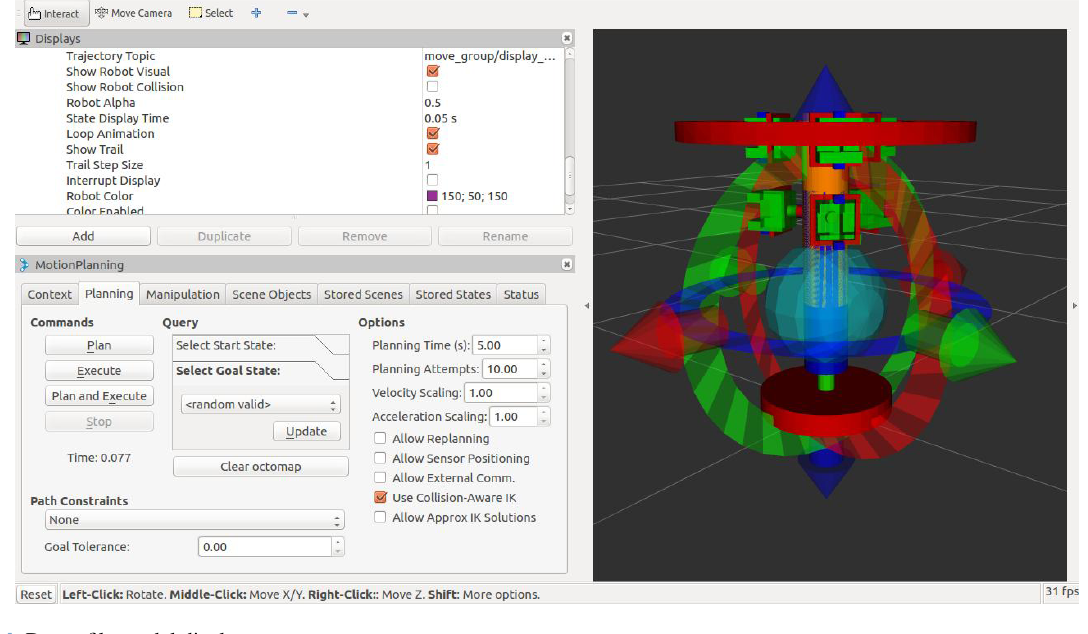
Figure 14. Demo file model display.